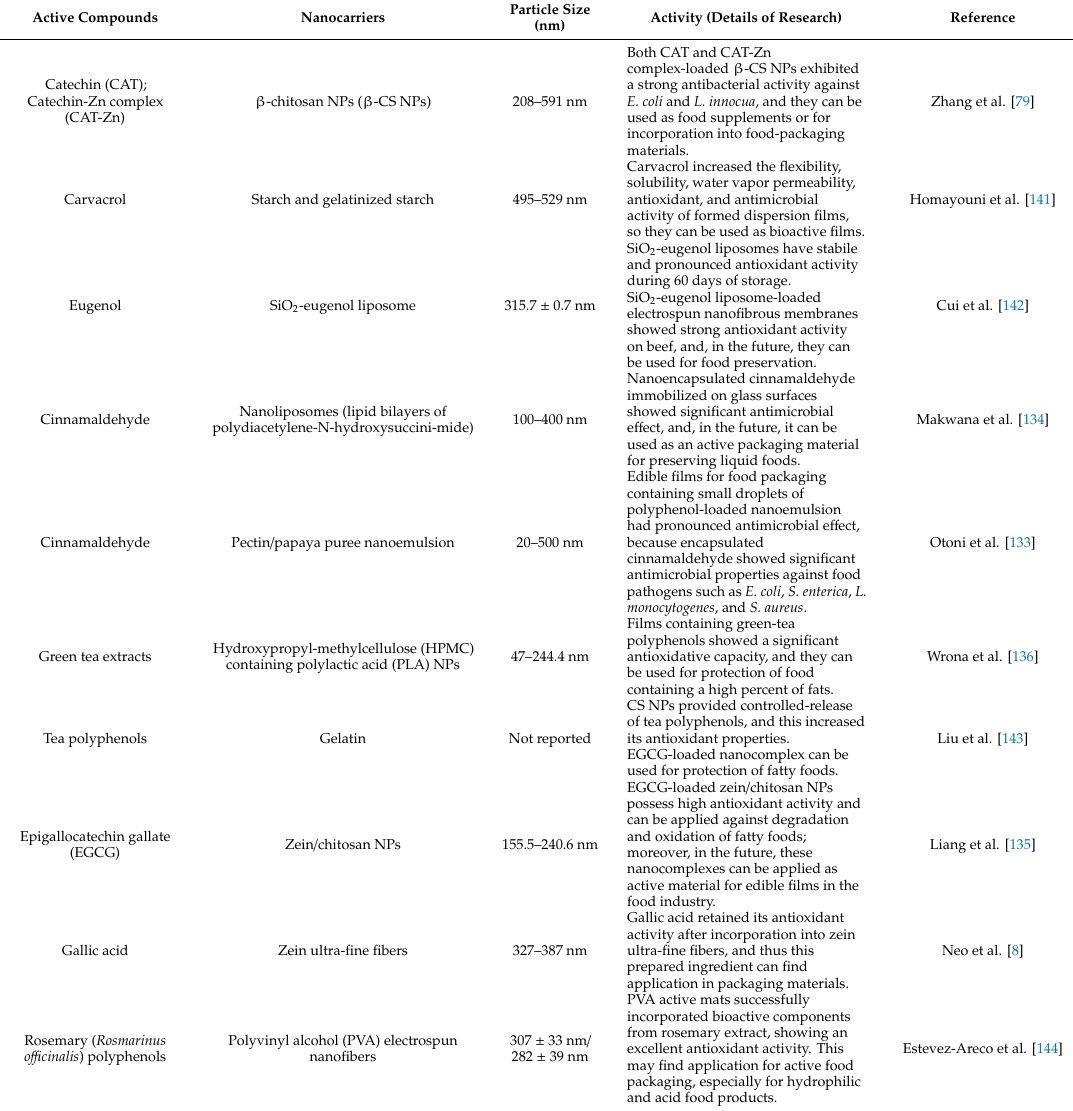
Table 3. Nanoencapsulation of phenolics important for food